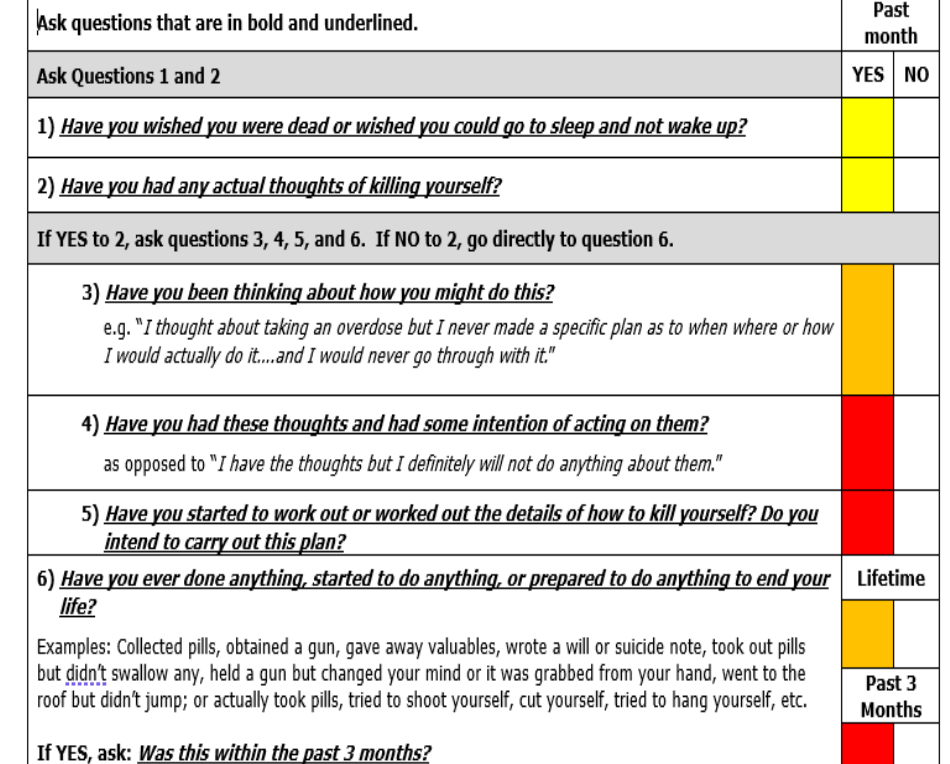
Figure 3. Columbia-Suicide Severity Rating Scale (C-SSRS): screen with triage points for primary care. Pay attention to question 2: if “Yes,” ask questions 3 through 6; if “No,” ask question 6. “Yes” responses in white boxes signify minimal risk; yellow boxes, low risk; orange, moderate risk; and red, high risk. Patients should be classified according to the highest risk box to which they reply “Yes”. Reproduced with permission from Dr Kelly Posner Gerstenhaber. The Columbia Lighthouse Project (https://cssrs.columbia.edu/ (accessed on 17 May 2021)).